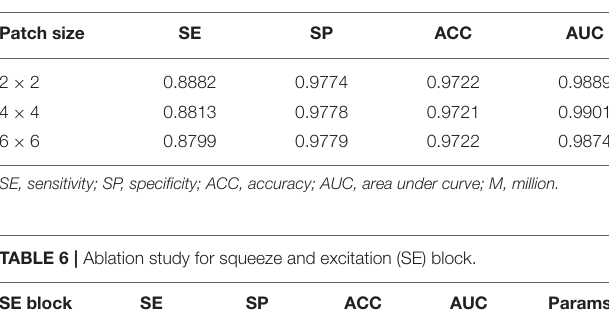
TABLE 5 | Ablation study for patch size of PAM.